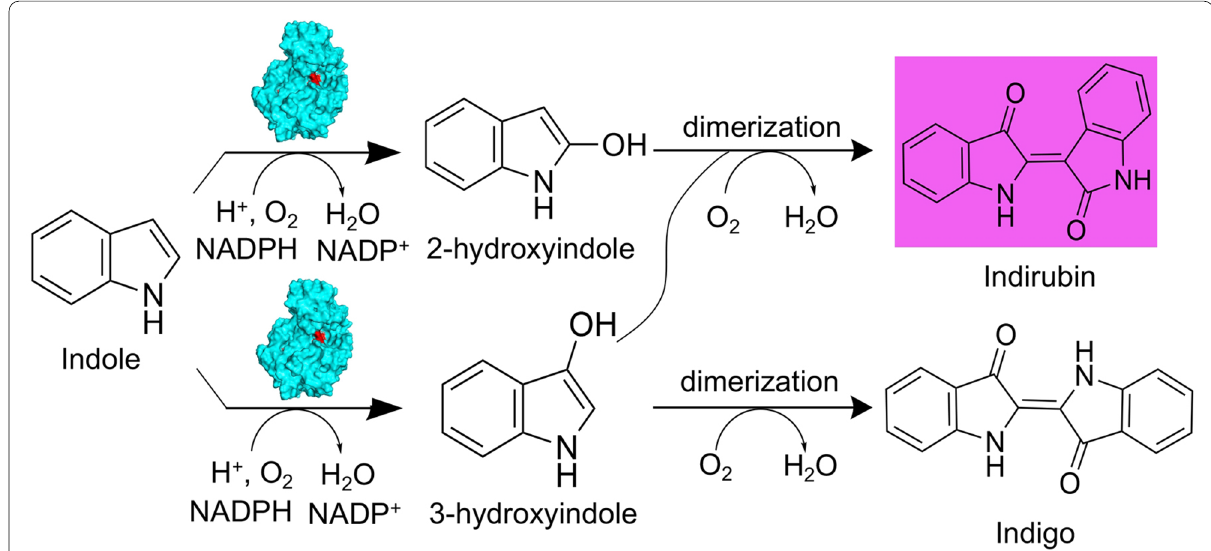
Fig. 1 Scheme of the bFMO‑mediated catalytic